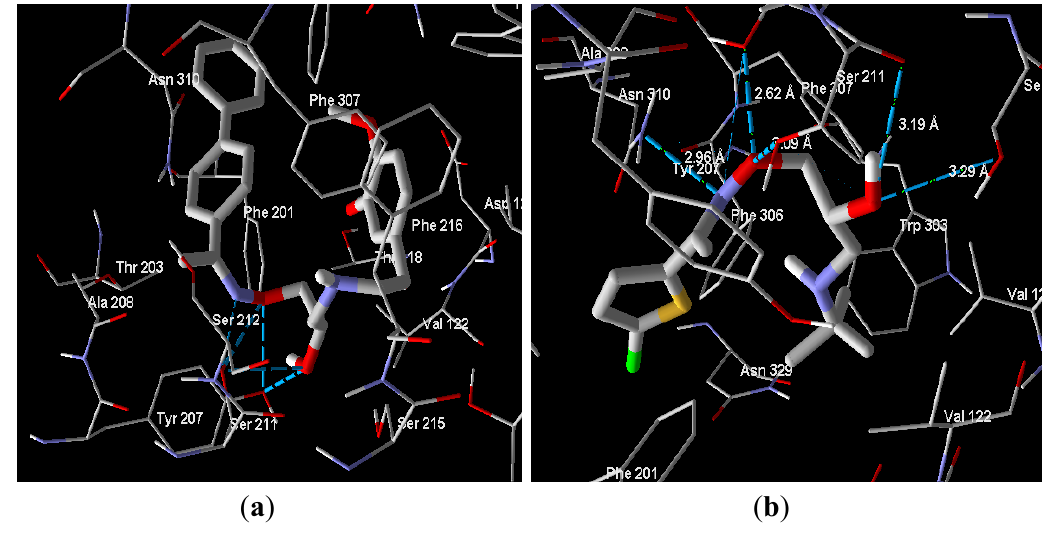
Figure 3. ( a ) Docking snapshot of compound 4o with β receptor. ( b ) Docking snapshot of 1 compound 4q with β receptor. Compounds are represented as stick (thick lines) while the 2 amino acids of the active site of the β 2-adrenoreceptor appear as (light) lines. Hydrogen atoms in both ligands and receptors have been omitted for clarity. Blue dashed lines indicate the hydrogen